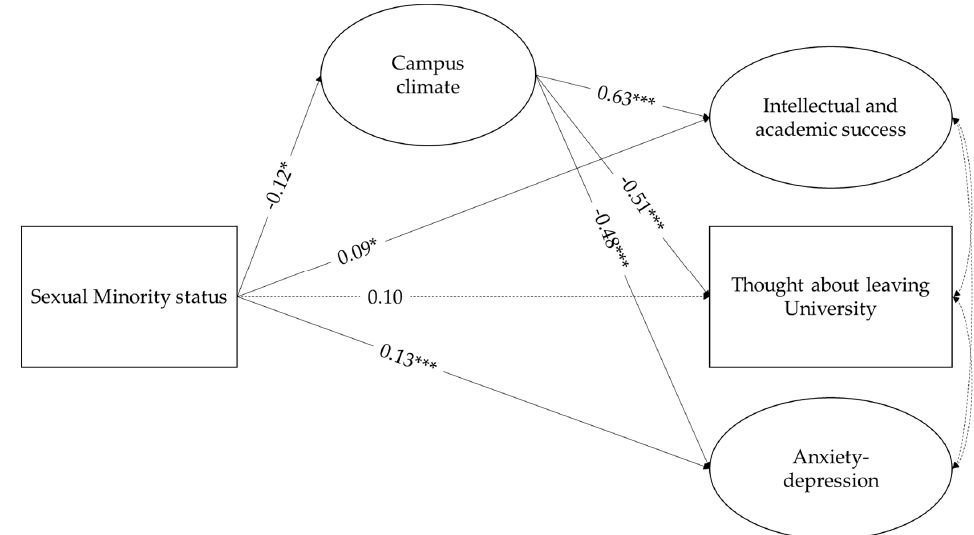
Figure 1. The associations between sexual minority status, campus climate perceptions, and health and academic outcomes. Higher scores of campus climate reflect more positive evaluations. *** p < 0.001, * p < 0.05.